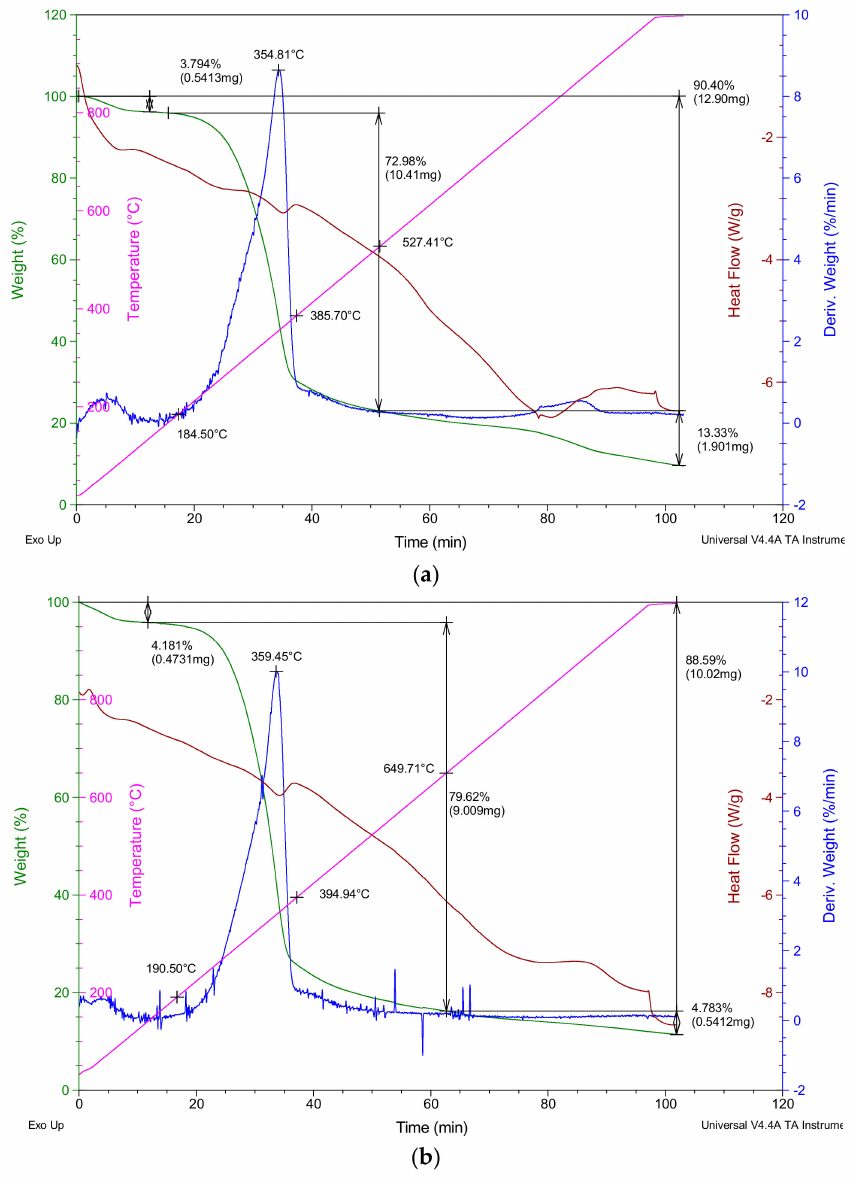
Figure 3. Thermogravimetric analysis (TGA) results. ( a ) Sawdust; ( b ) wood